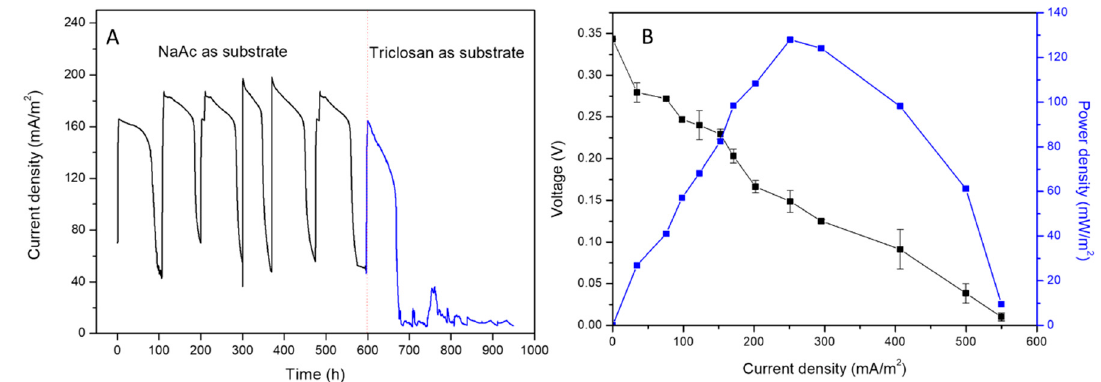
Figure 2. The profile of current generation ( A ) The profile of current density with NaAc or TCS feeding ( B ) Polarization curve and power density curve.